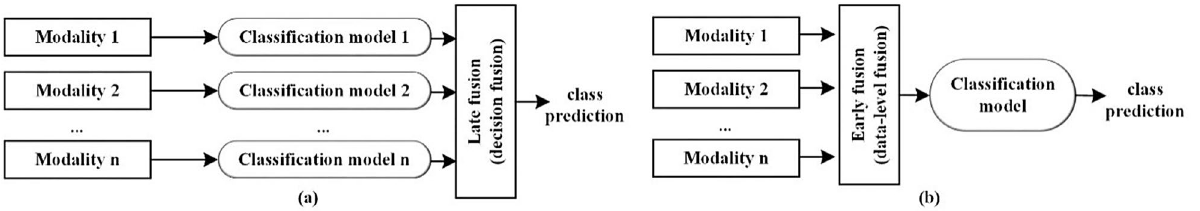
Figure 7. Multimodal fusion strategies: ( a ) late fusion, ( b ) early